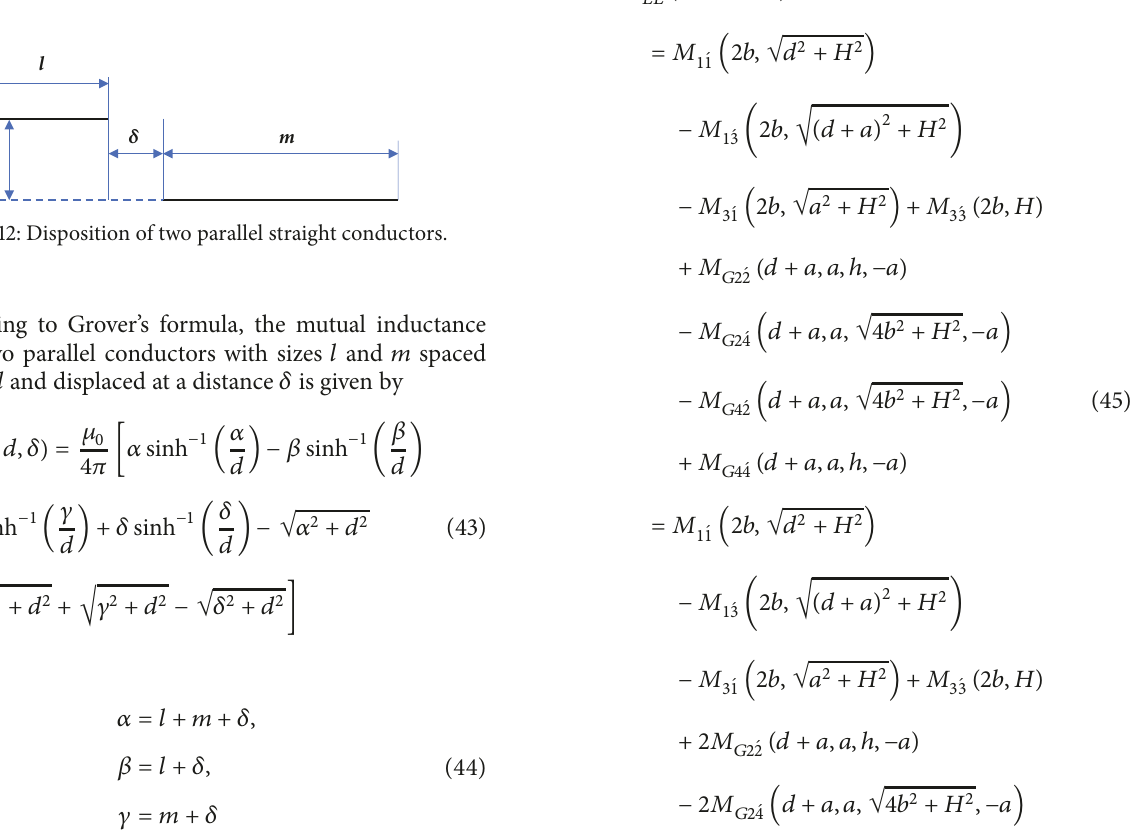
Figure 11: Geometry for calculating the mutual inductancebetween two parallel and coaxial rectangular loops with the same dimen- sions.